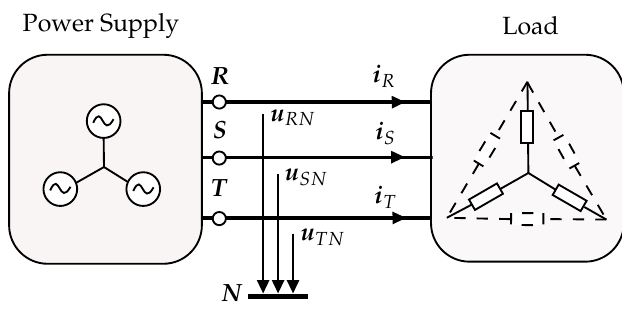
Figure 1. Three-phase three-wire electrical circuit.